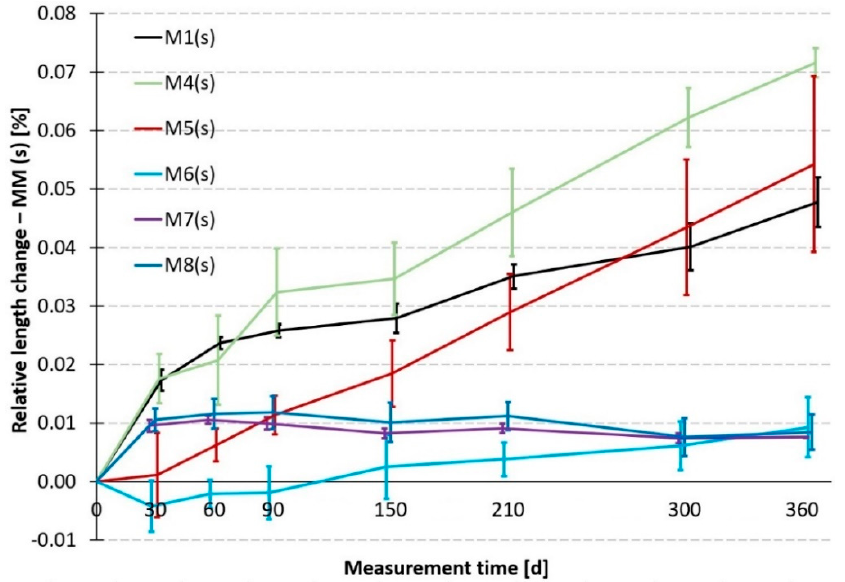
Figure 13. Dependence of relative length changes on the immersion time of samples in the sulfate bath (detail).